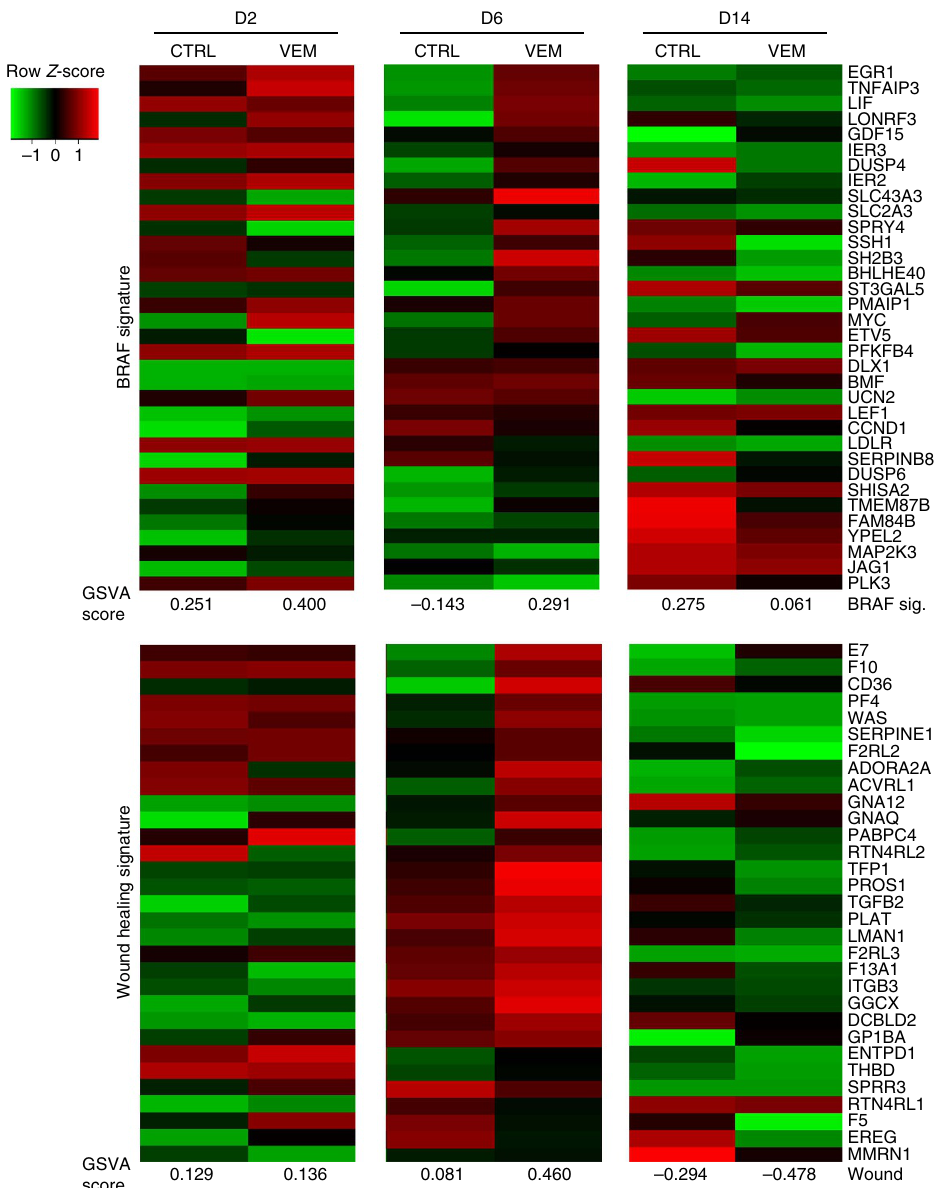
Figure 4 | Gene expression profiling of cutaneous wound healing in mice. Full-thickness skin resected around the areas of the initial wound was analysed for gene expression profiling by RNASeq. Top, Expression, regulation and overall enrichment of BRAF signature genes as measurement of MAPK pathway activity. Bottom, expression changes and enrichment of wound-healing signature genes (GO: 0042060). There is enrichment of the BRAF signature at day 2 and 6 in vemurafenib-treated wounds, with a significant increase of the wound-healing signature at day 6. Enrichment scores, GSVA (the scores are normally distributed around 0 where negative values indicate relative de-enrichment of the signature and positive values indicate